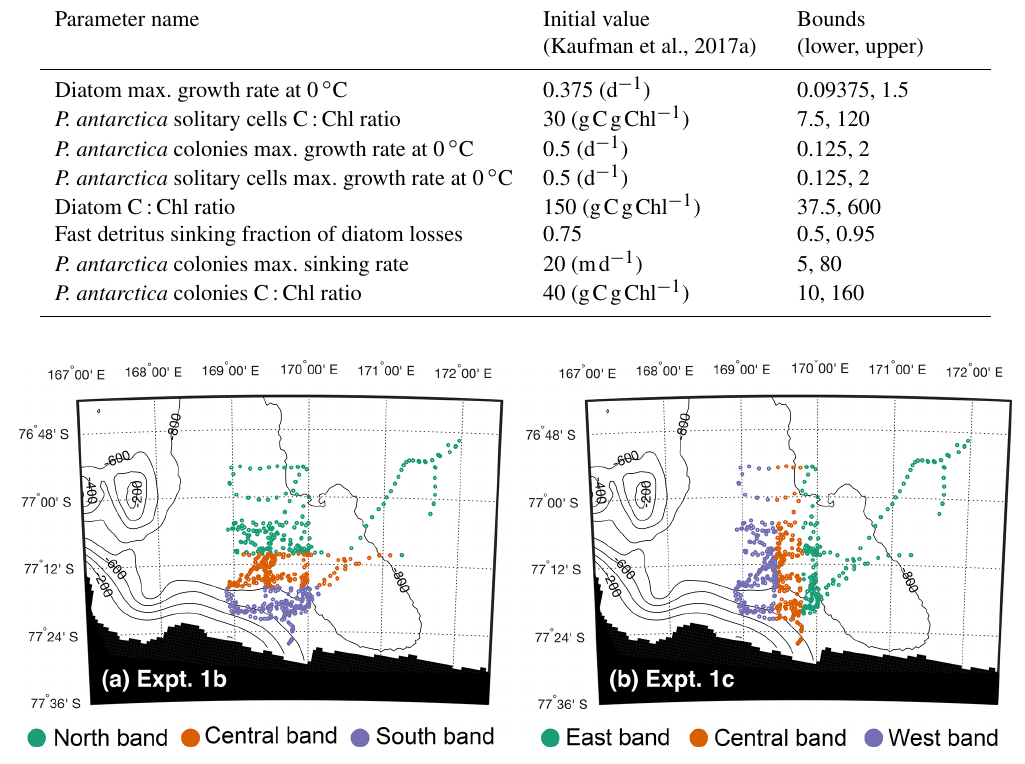
Figure 4. Locations of glider observations assimilated in (a) Experiment 1b – latitudinal bands – and (b) Experiment 1c – longitudinal bands. Colors represent the three spatial bands of data